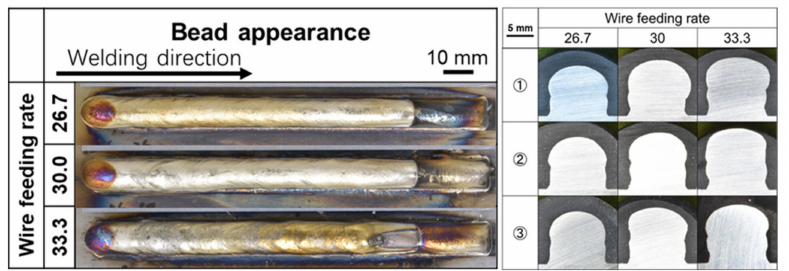
Figure 8. Bead appearances and cross sections for 5.5-kW laser power and a process speed of 0.36 m/min.